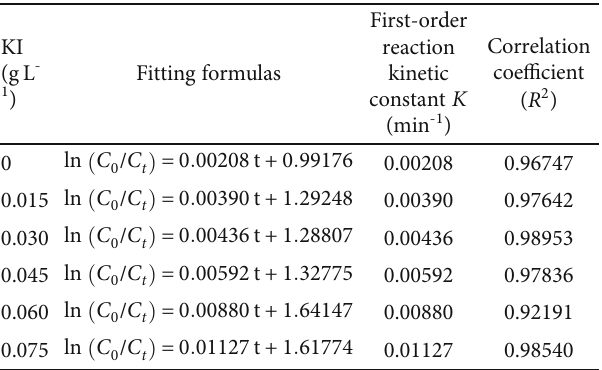
Table 4: Fitting results of fi rst-order reaction kinetics under alkaline condition ( pH = 9 : 37 ).